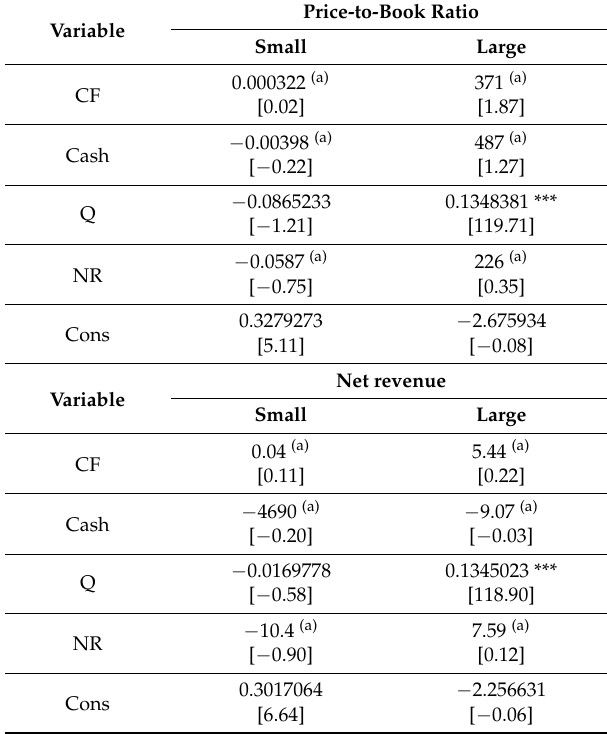
Table 6. Summary regression results by sub-samples based on three criteria by